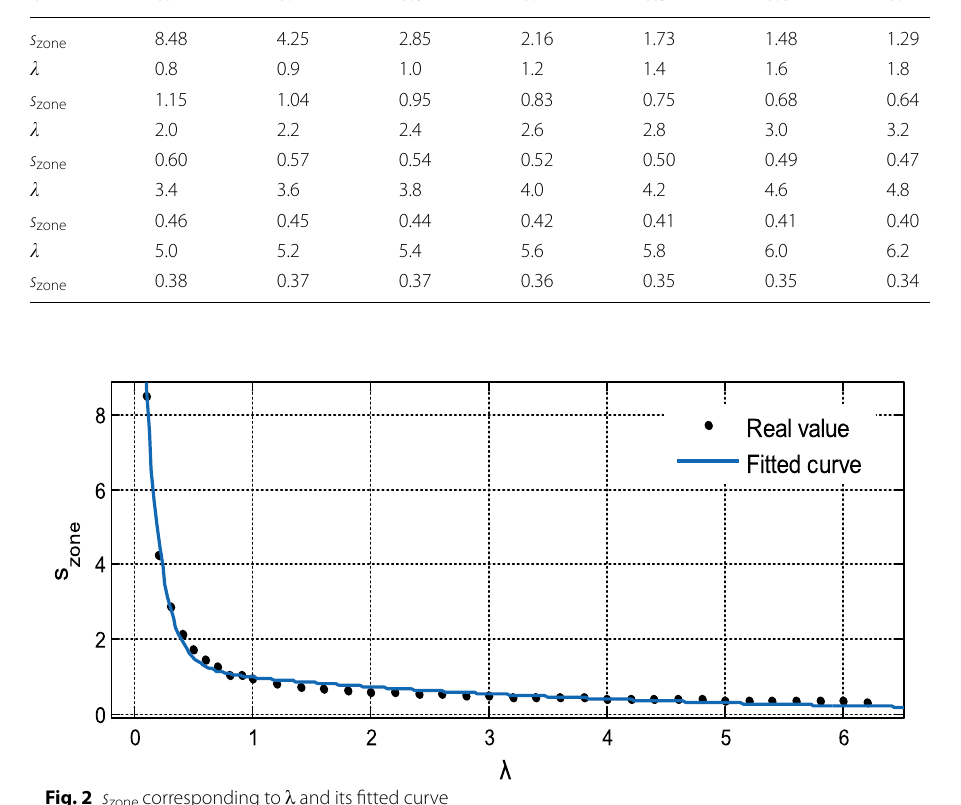
Fig. 2 s zone corresponding to (cid:31) and its fitted